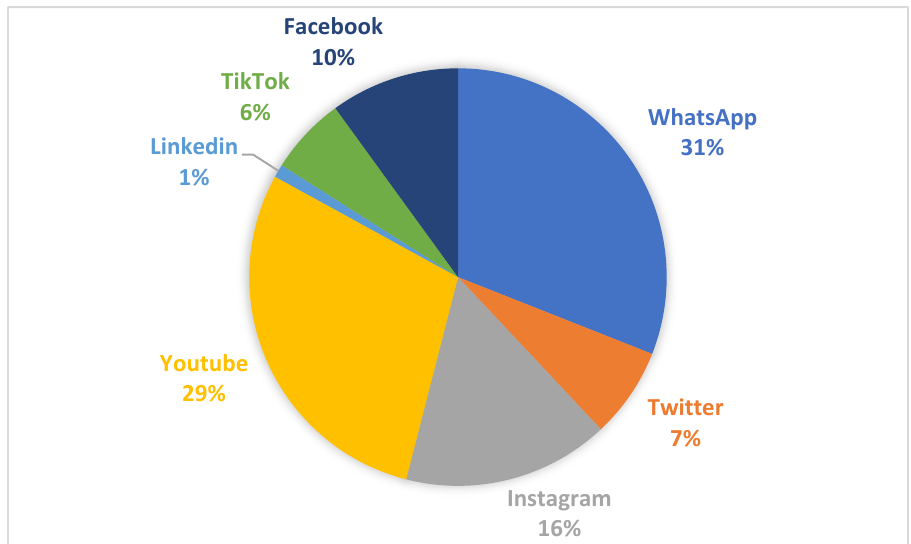
Figure 1. Preferred social media channels for disseminating plastic pollution messages.